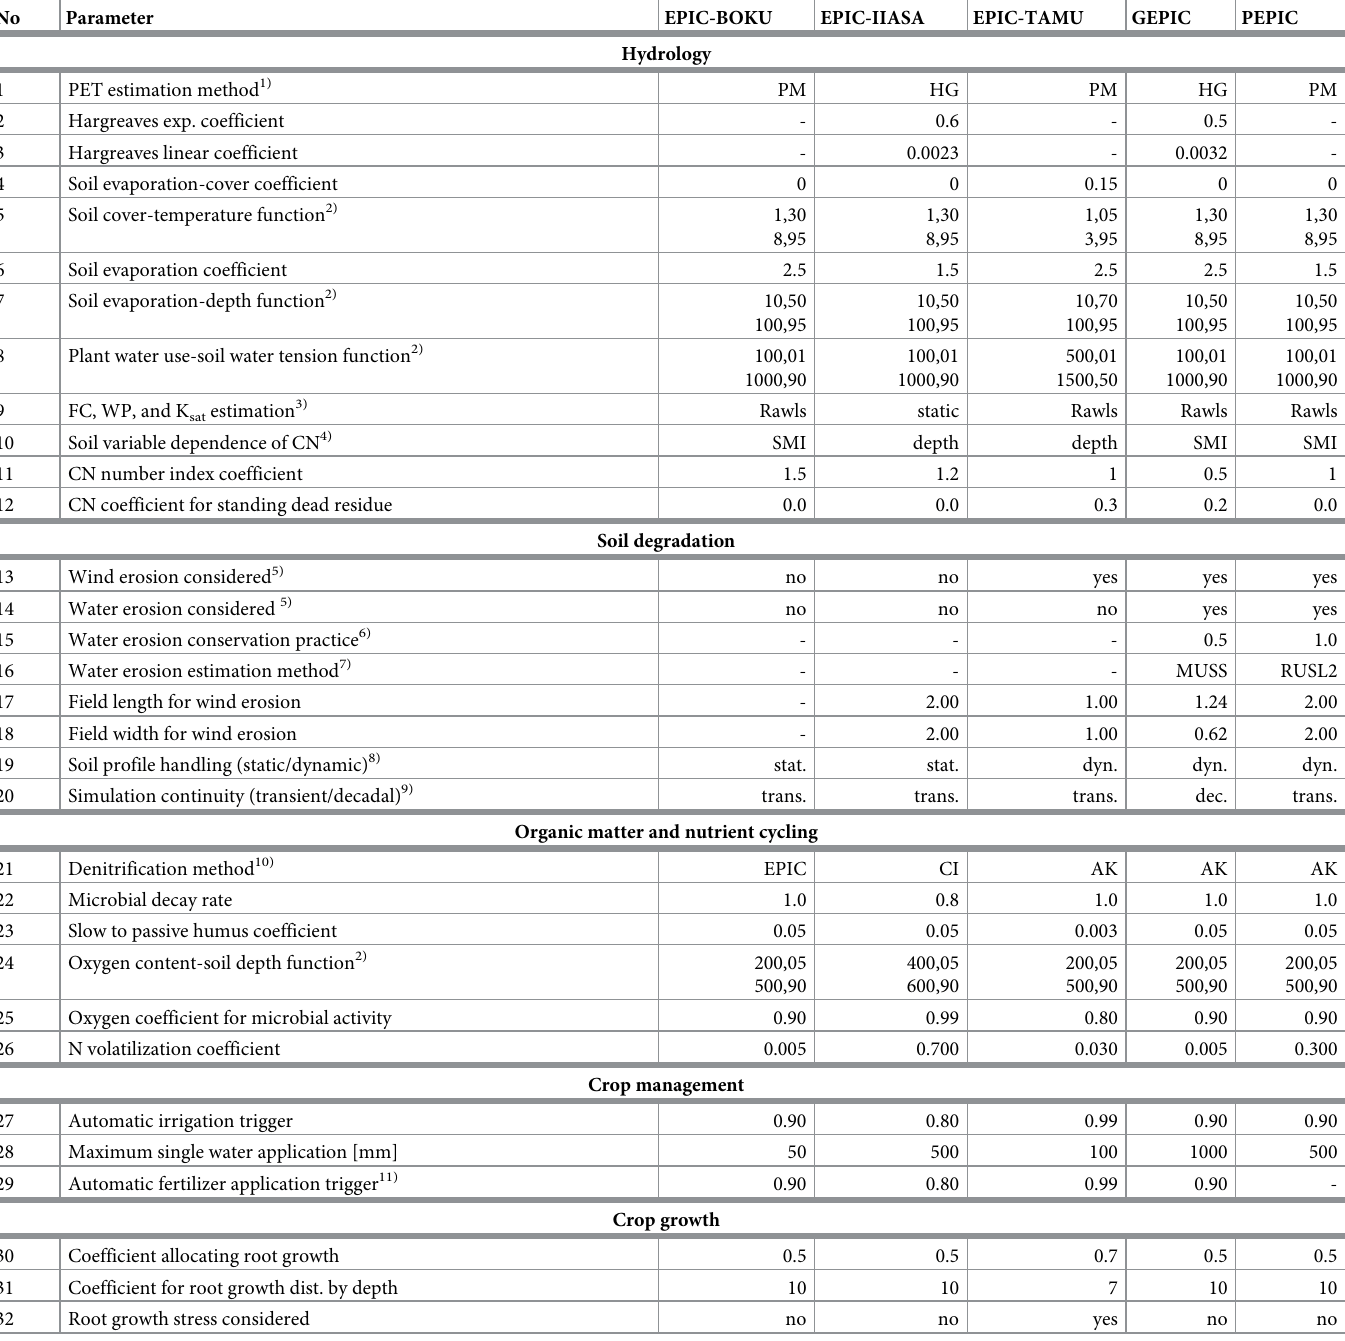
Table 2. Differences in parameters and choice of subroutines for the participating EPIC-based GGCMs. A dash indicates that the parameter is not relevant for the respective GGCM due to selection of subroutines. A brief explanation of parameters is provided in Table B in S1